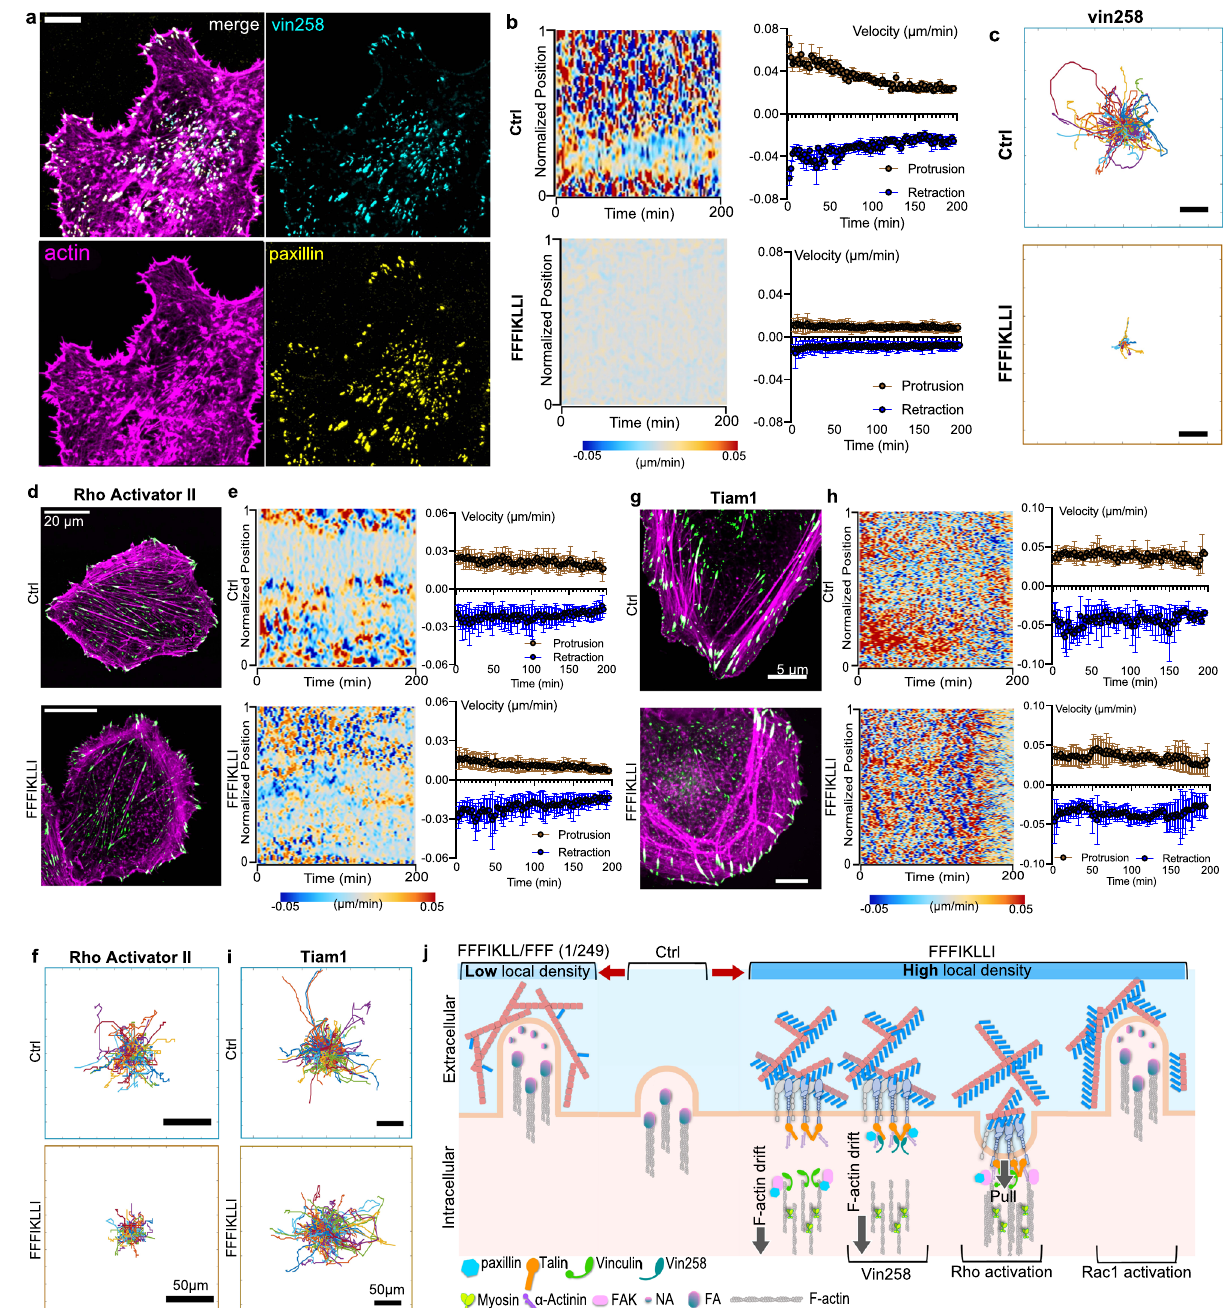
Fig. 5 | Overcome the in fl uence of super high density of ligands via Rac1 signaling. a F-actin phalloidin(magenta), vinculin N-terminaldomainlacking thetaildomain(vin258)(cyan),andpaxillin(yellow)immuno fl uorescenceinHuH-7 cellexpressing pEFGPC1/GgVcL 1-258upon the treatment ofFFFIKLLI(100 μ M) for 12h. Scale bar represents 5 μ m. b Kymograph of normalized edge velocity and mean velocity over time for protrusions and retractions of HuH-7 cells expressing pEGFPC1/GgVcL 1-258 with or without the treatment of FFFIKLLI for 12h. n =10 cells. Data are presented as mean±s.d. c The trajectory plots of ~200 randomly selected migrating HuH-7 cells expressing pEGFPC1/GgVcL 1-258 with or without the treatment of FFIKLLI. Scale bars represent 50 μ m. F-actin phalloidin staining (magenta) and paxillin (green) immuno fl uorescence (three independent experi- ments were performed) d , kymograph of normalized edge velocity and mean